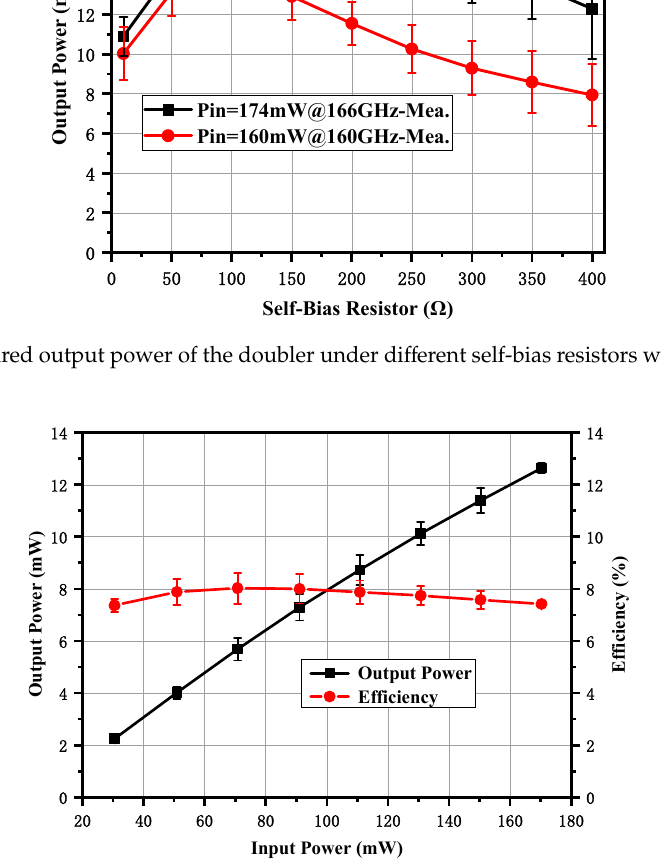
Table 3. Comprehensive comparison of reported frequency multipliers.